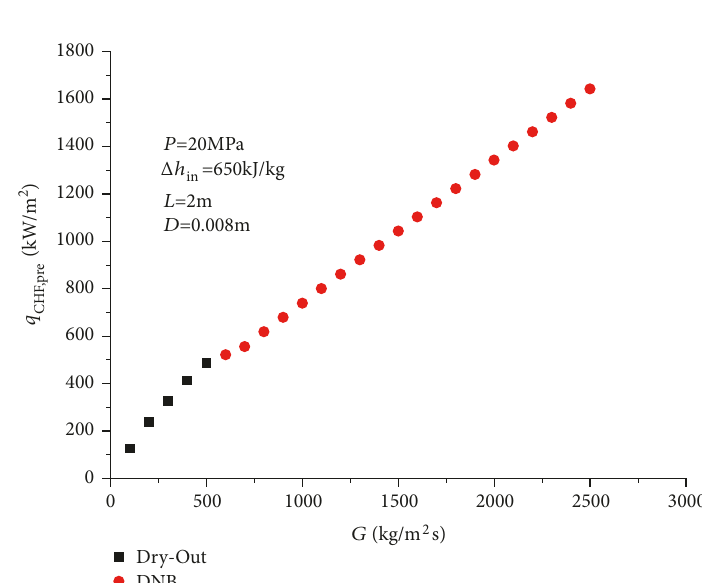
Figure 8: Continuous variation of CHF with mass